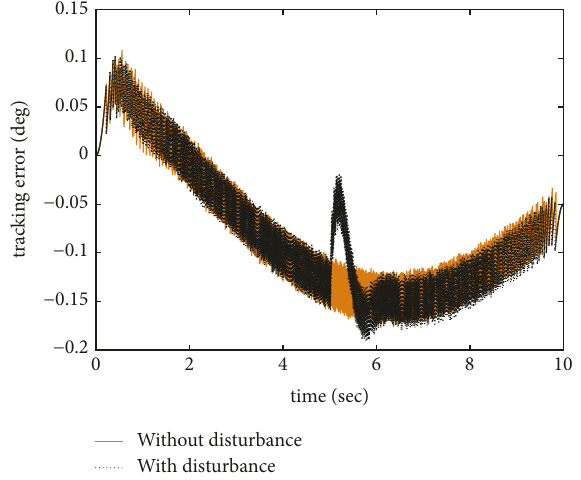
Figure 10: Two tracking error curves of PI